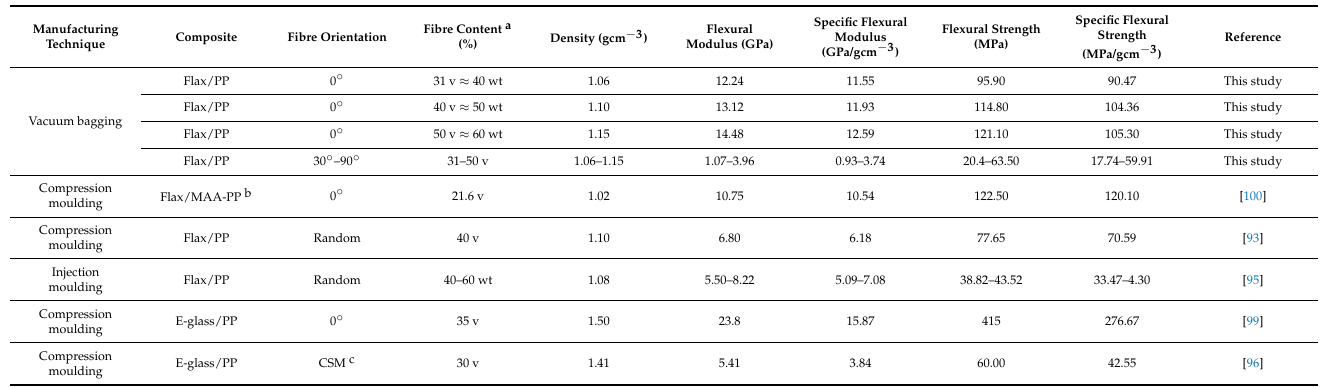
Table 4. A comparison of flexural properties of the manufactured flax/PP composites with E-glass/PP and flax/PP composites found in the